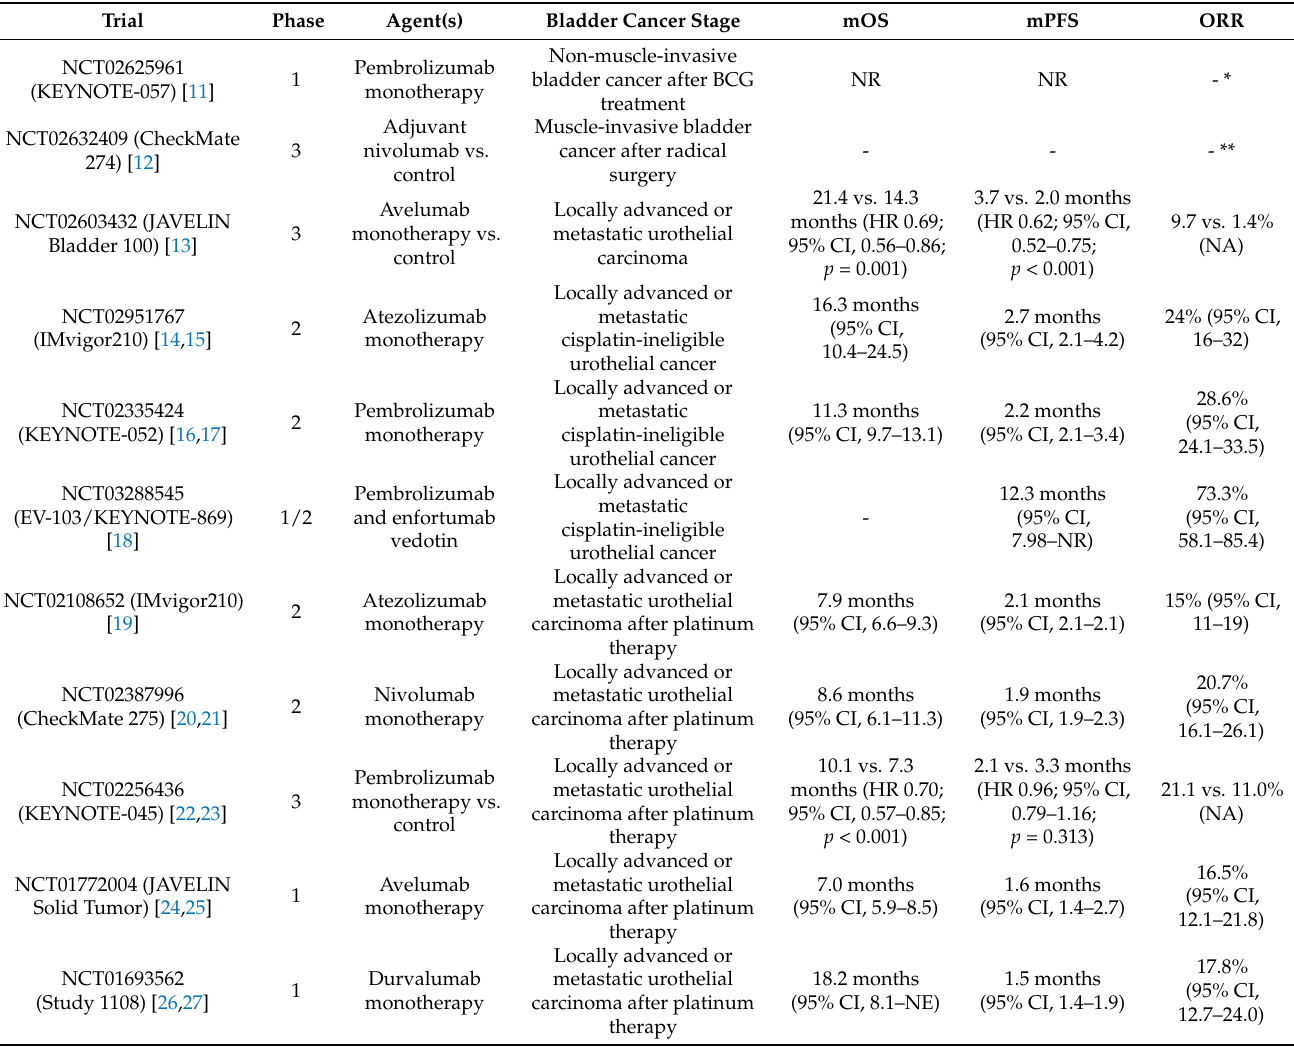
Table 2. Trials with immune checkpoint inhibitors at various stages of bladder cancer leading to approval for